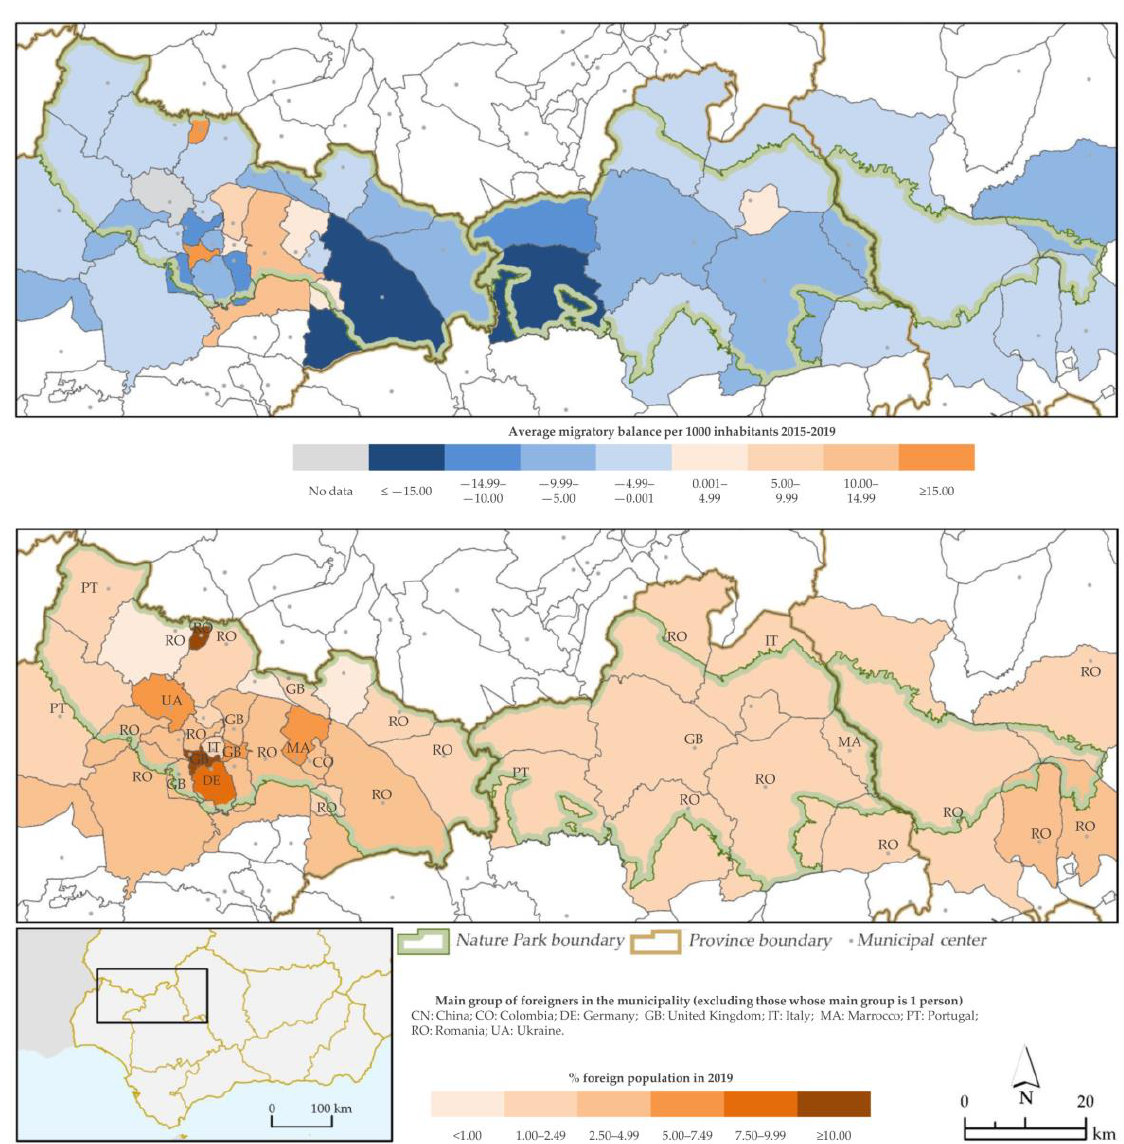
Figure 20. Migratory balance for 2015 – 2019 per 1000 inhabitants (upper map), and percentage of foreign population and the main group of foreigners in the municipality (lower map). Source: [85]; authors ’ elaboration.